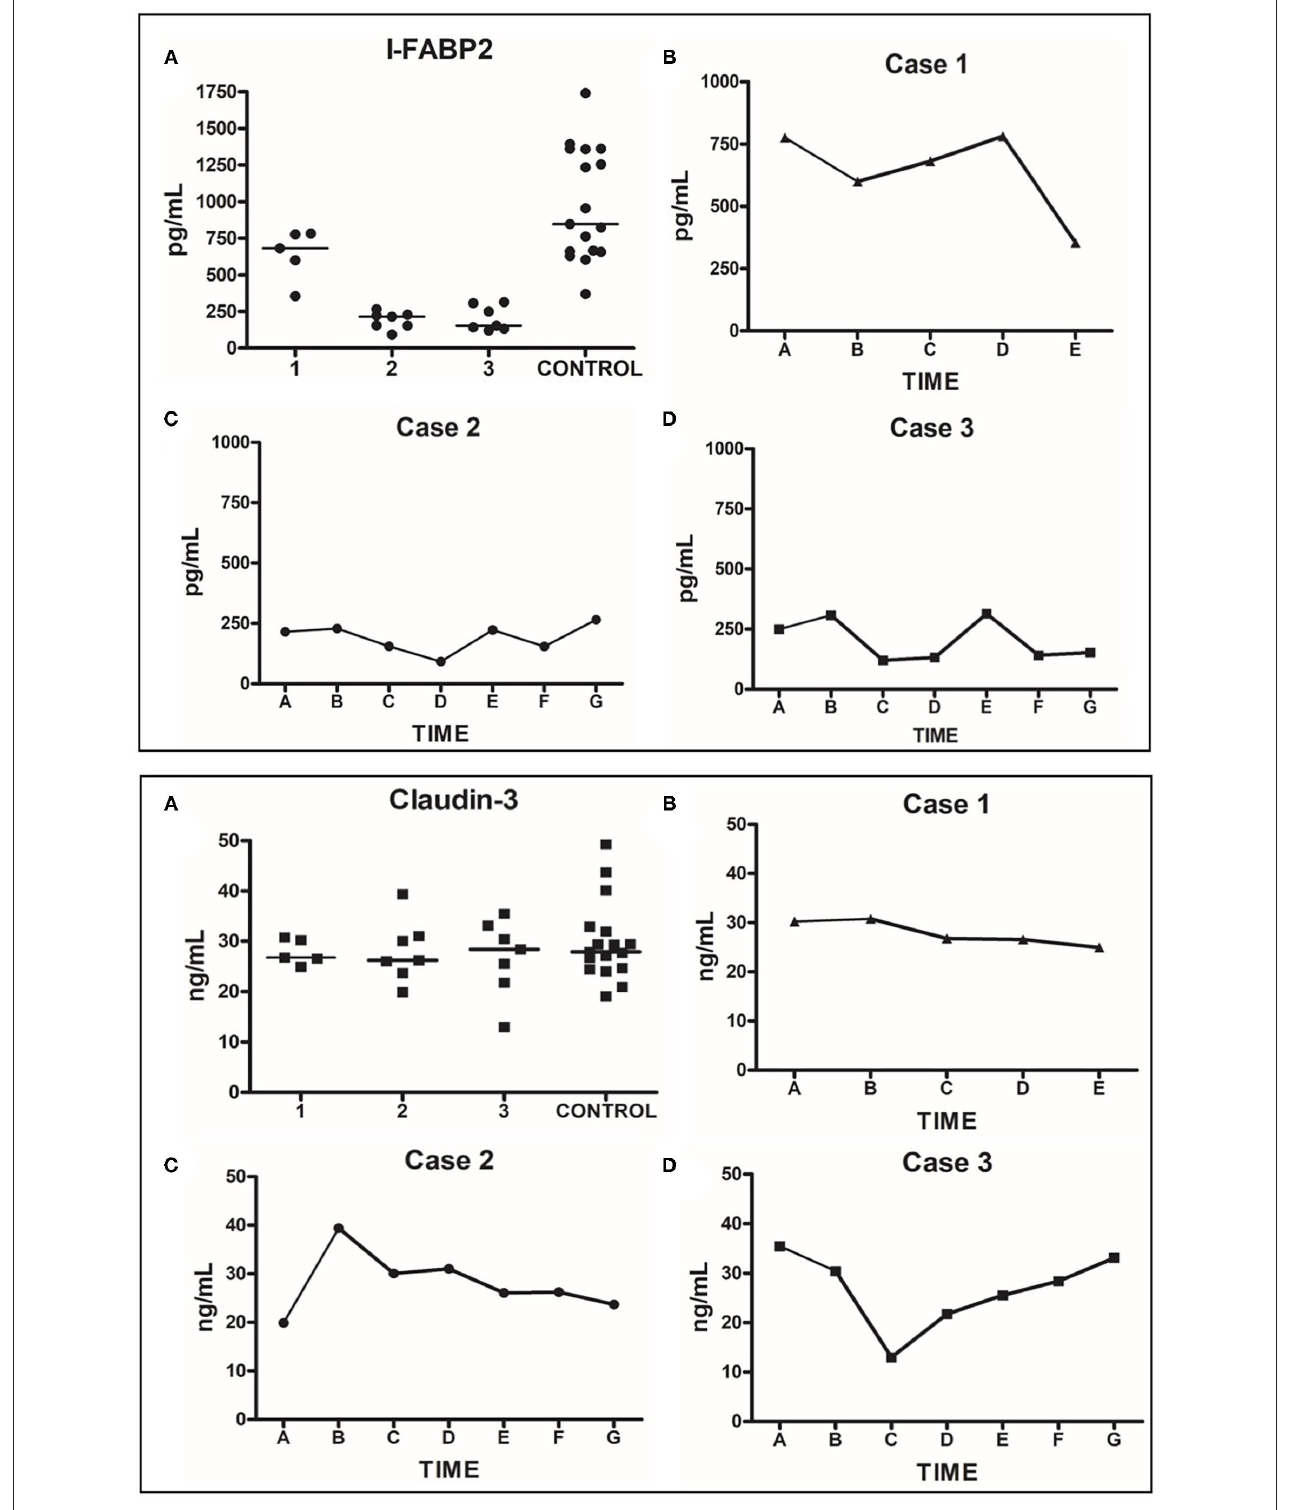
FIGURE 4 | Human plasma I-FABP2 and Claudin-3 analysis. Top Panel: I-FABP2. (A) Grouped values for each patient during their hospitalization compared to grouped values of controls. (B) Daily sequential values for Case 1; time point A represents day 7 of hospitalization (day 3 of anakinra), when patient was